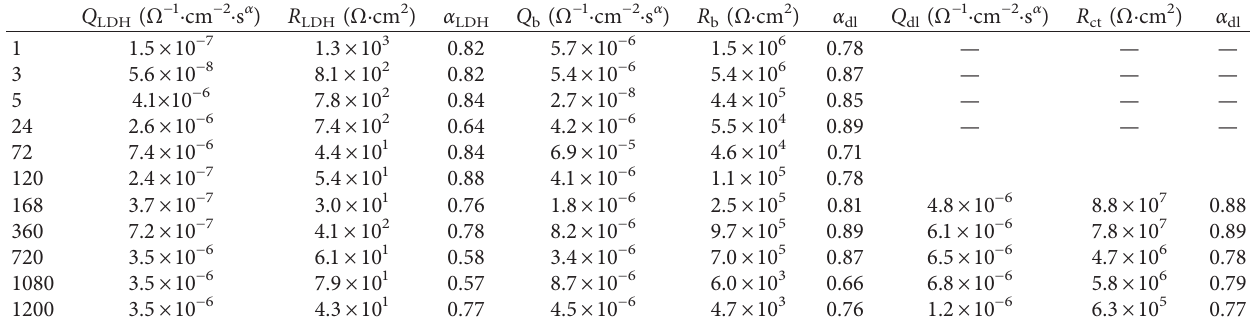
Table 3: Results of the EIS fittings of CeLDH-H.